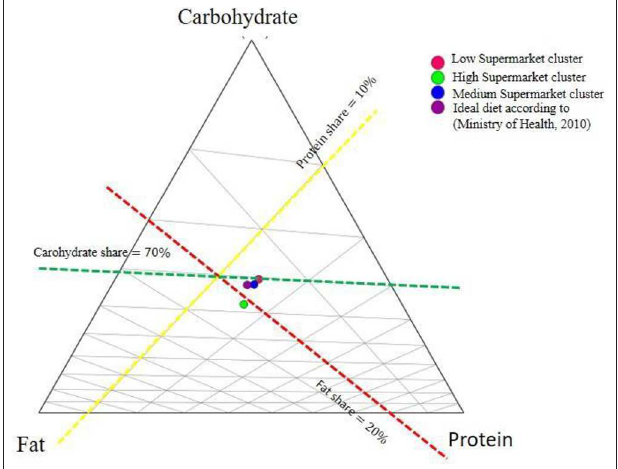
FIGURE 5 | Ternary diagram of average macronutrient shares for each supermarket cluster. A ternary diagram is a triangular coordinate system where the edges of the triangle are the axes. Each axe is associated with a component with a variation from 0 to 100%. So, for example, the axis from the top titled “Carbohydrate” to the top “Protein” is associated with the variation in protein component. The location of the vector with S P S C 70 % are added to make this diagram reading =